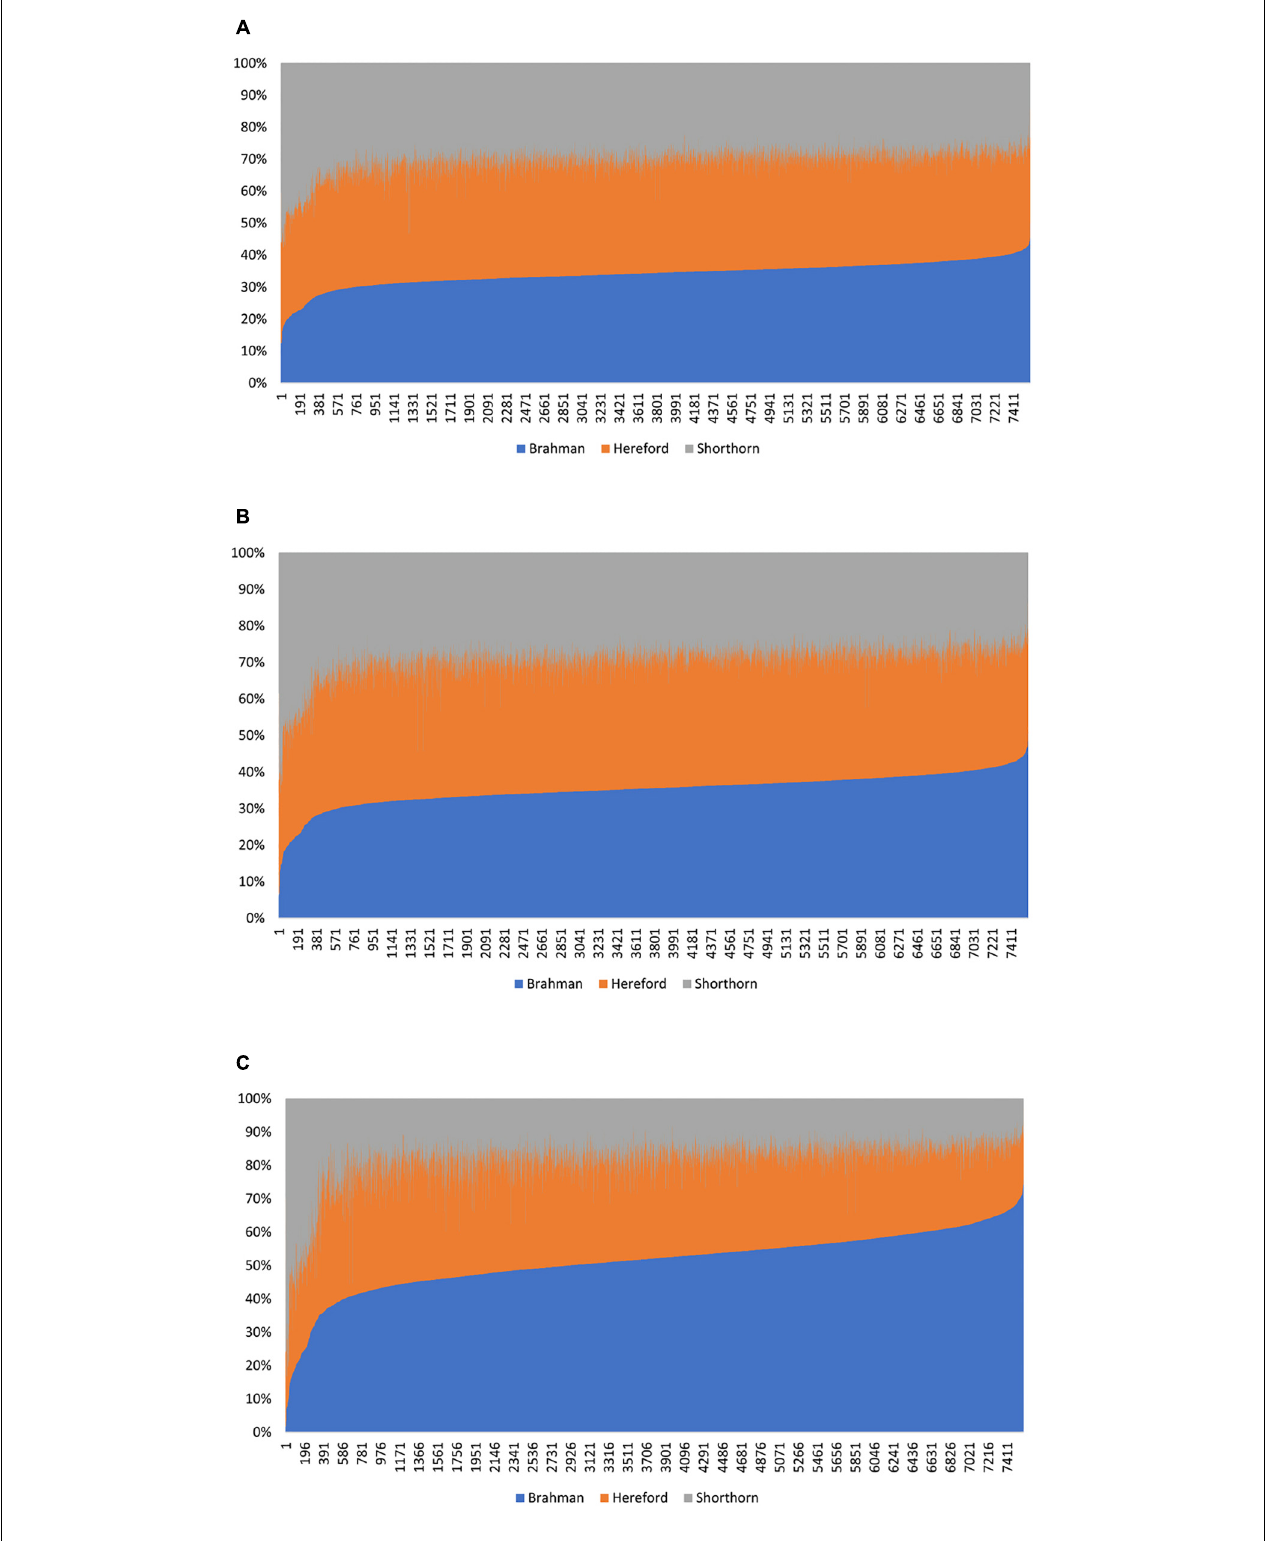
FIGURE 4 | Distribution of the estimated genomic breed composition for 7,605 Beefmaster animals in ascending order of their Brahman composition, obtained using three statistical methods: (A) admixture model, (B) linear regression, and (C) path analysis (D-GBC).